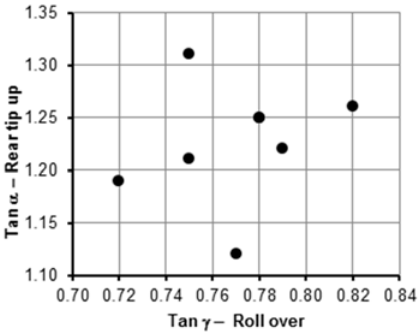
Figure 4. Static instability for rear longitudinal versus lateral directions for eight work QBs; two sets of data values at (0.78:1.25) coincide.